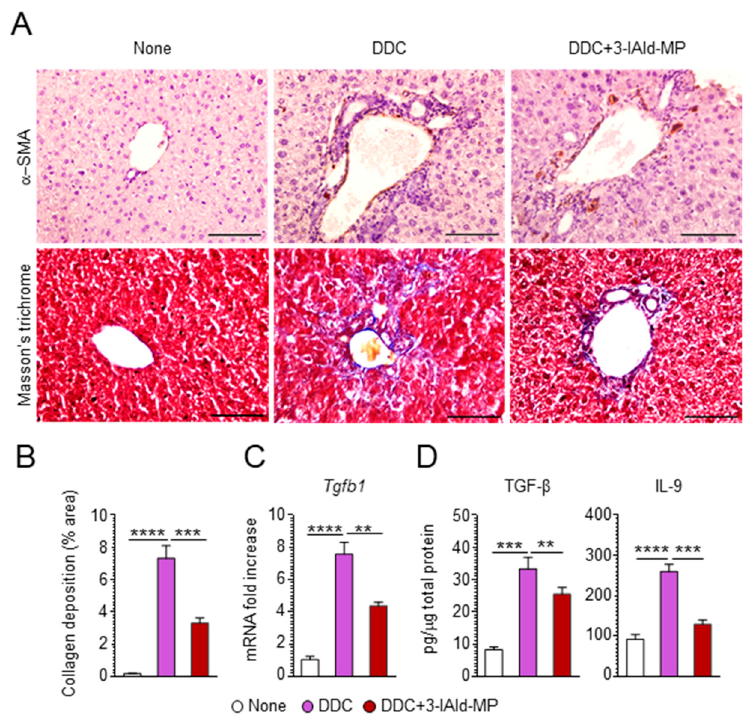
Figure 3. 3-IAld-MP alleviates liver fibrosis. C57BL/6 mice were fed for 14 days with a 0.1% DDC- containing diet and subjected to a recovery time of 14 days. The mice were treated intragastrically with 3-IAld-MP every other day throughout the experiment, as depicted in Figure 2. The mice were evaluated for ( A ) fibroblast activation (immunohistochemistry for α -SMA), collagen deposition (Masson’s trichrome staining) and ( B ) quantification, in liver sections, ( C ) Tgfb1 expression by RT- PCR, and ( D ) TGF- β and IL-9 levels by ELISA in liver homogenates. Photographs were taken with a high-resolution microscope (Olympus BX51), 40× magnification (scale bars, 100 μ m). The data are presented as the mean ± SEM and are representative of three experiments ( n = 4 mice/group). ** p <